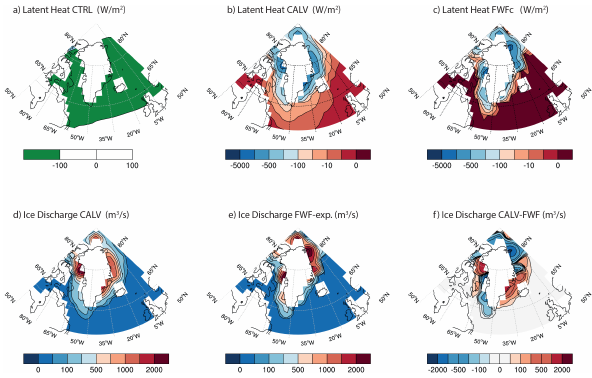
Figure 1. (a) Mask used in CLIO where the latent heat needed to melt the excess snow is homogeneously taken up to parameterise icebergs; (b) take-up of latent heat from the ocean surface due to iceberg melting in CALV; (c) take-up of latent heat from the ocean surface due to local release of ice discharge (FWFc) (non-linear colour scheme); (d) 1000-year averaged iceberg meltwater fluxes (m 3 s − 1 ) of the CALV experiment; (e) 1000-year averaged meltwa- ter flux due to calving put into the ocean directly at the ice-sheet margin (same for both FWF experiments); (f) difference between iceberg melt flux and direct freshwater flux (CALV–FWF) (non- linear colour